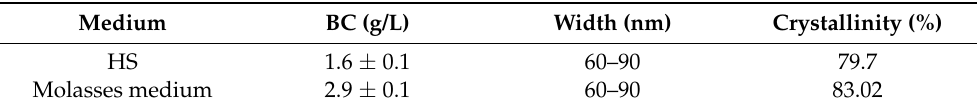
Table 1. BC yield, width of cellulose microfibrils by AFM and crystallinity by X-ray diffraction. HS—Hestrin and Schramm.